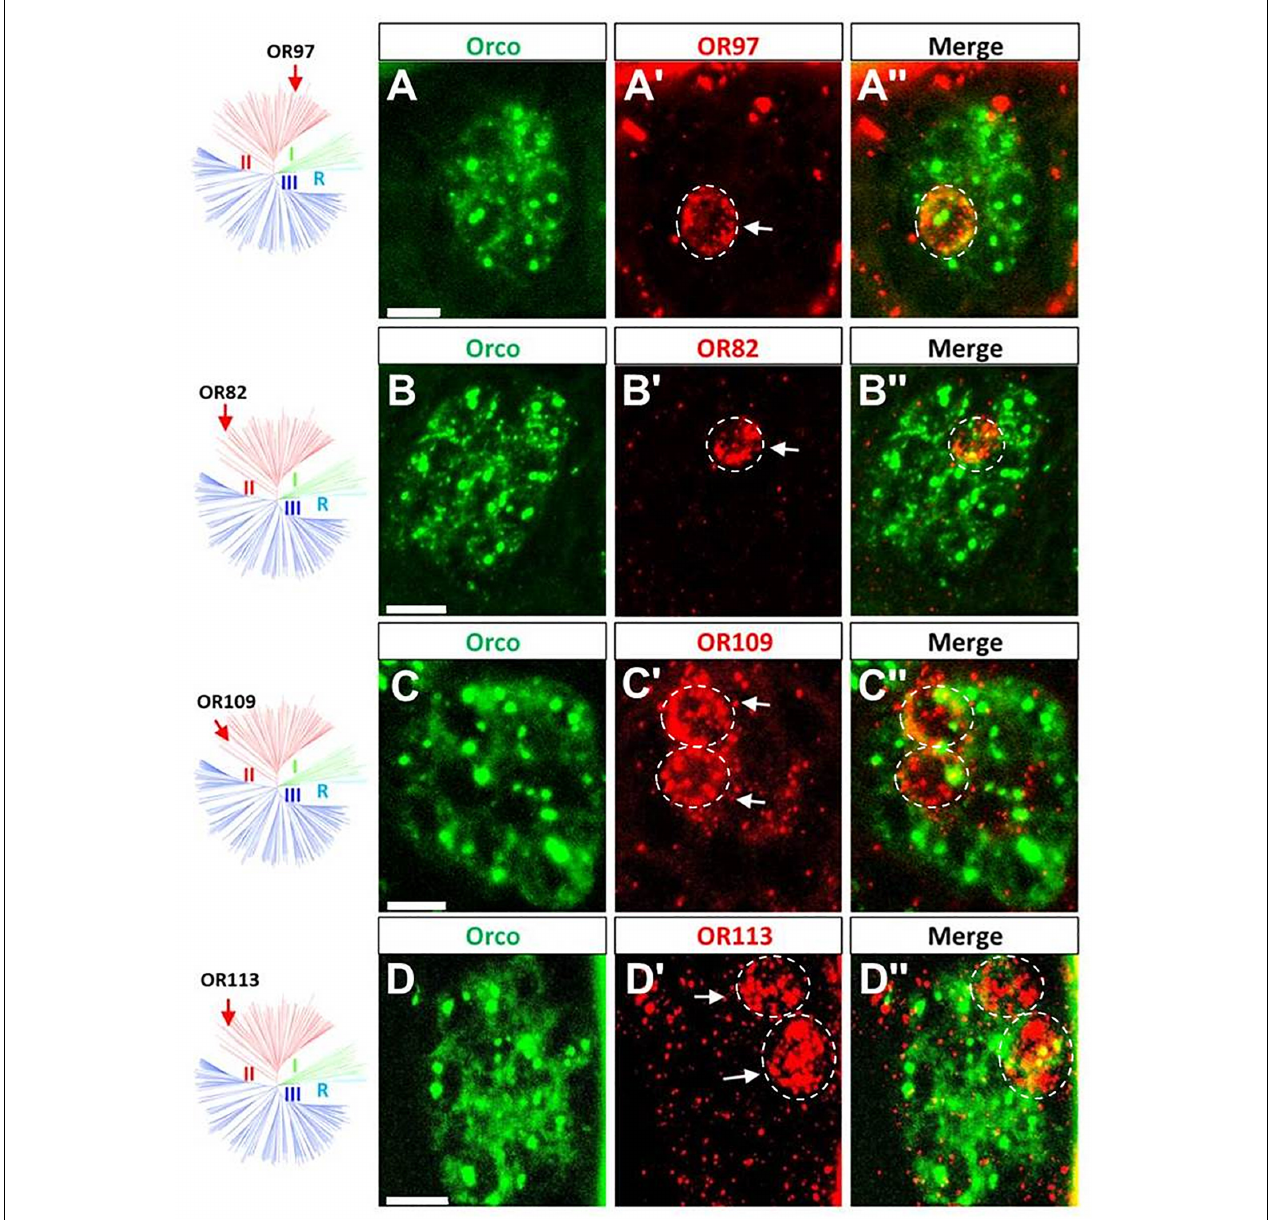
FIGURE 2 | The majority of group II ORs are specifically expressed in sensilla basiconica. (A–D”) The Orco- and distinct OR-expressing cells were visualized by means of two-color FISH using specific antisense riboprobes labeled in Bio (green fluorescence) and DIG (red fluorescence), respectively. The four ORs (OR82, OR97, OR109, and OR113) are shown as representatives of group II ORs that are specifically expressed in sensilla basiconica. The white dash circle highlights the cell that concomitantly expresses a defined OR type and Orco. More examples are shown in the supporting data. Distinct OR cells are indicated by white arrows. Scale bars, 10 µ